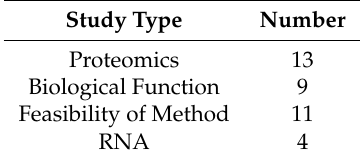
Table 3. Omics approaches of studies